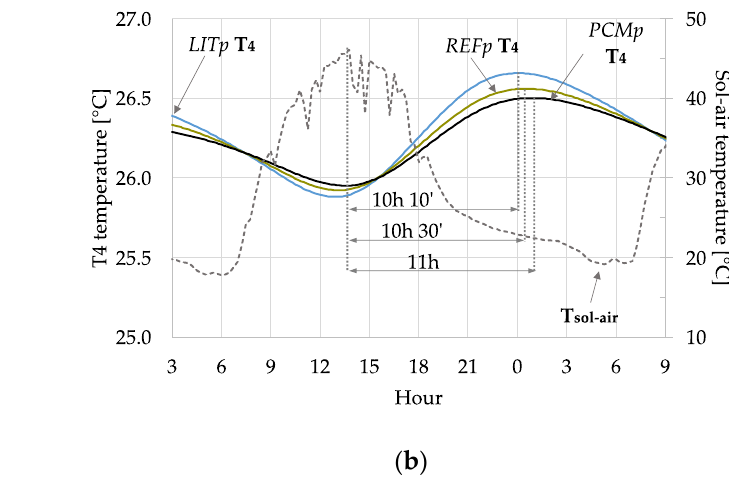
Figure 12. ( a ) Percentage comparison between the incoming energies in the case of the two-brick-thick wall; ( b ) detail of the temperature on the inner side of the wall for one of the days of the simulation and relative delay from T sol-air peak temperature for the two-brick-thick wall.